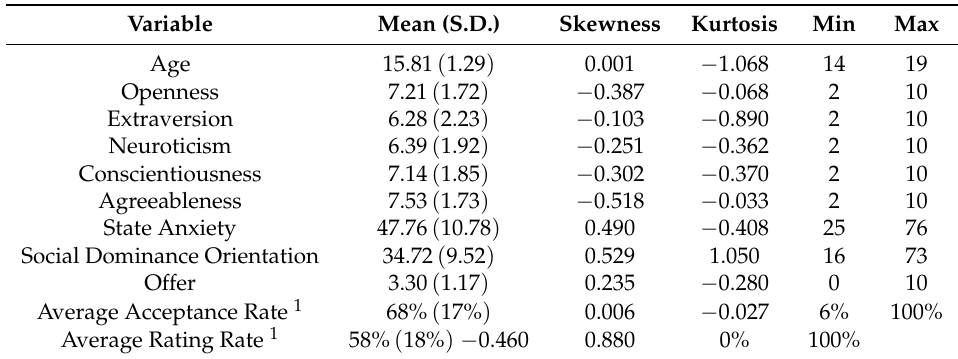
Table 2. Descriptive statistics of Socio-demographic Characteristics and Operative Variables. In the table are reported the psychometric features of the Socio-demographic Characteristics, the Psychological Traits, and the Game’s Operative Variables.